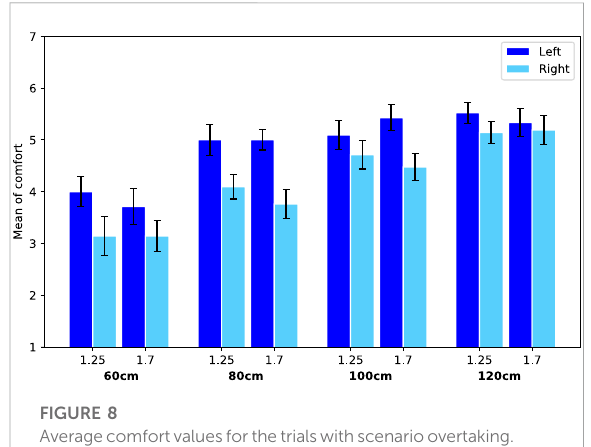
FIGURE 8 Averagecomfortvaluesforthetrialswithscenarioovertaking. Error bars represent Standard